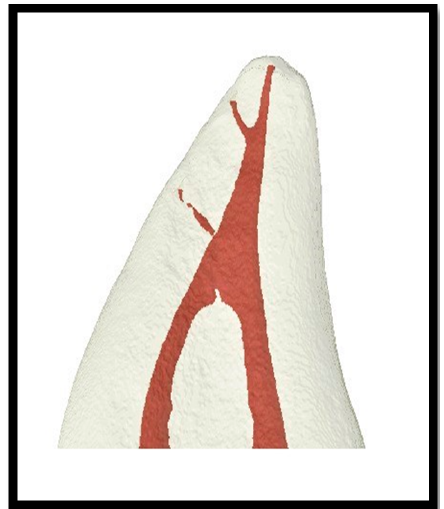
Figure 12. Micro-CT image showing the apical third location of the accessory canal.